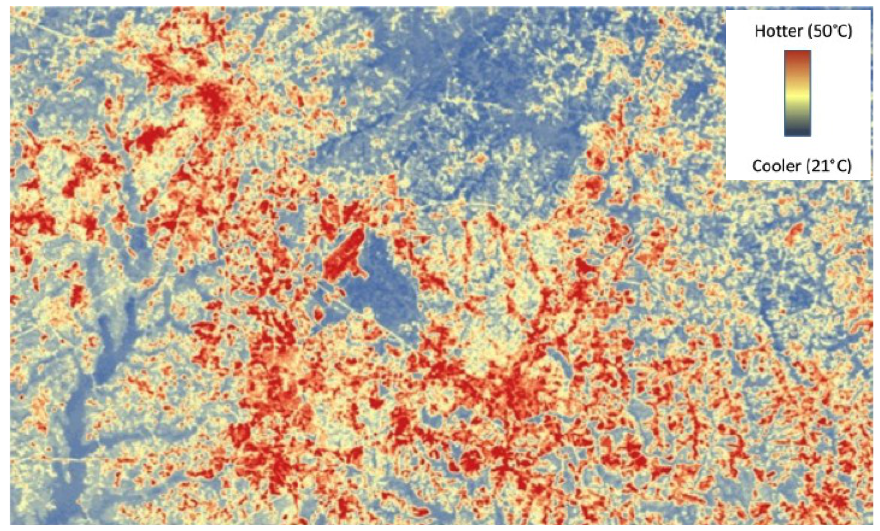
Figure 1. Relative temperature (UM-RH) over Raleigh, NC, and the surrounding area. Values determined from readings on 18 August 2007 (see [45] for